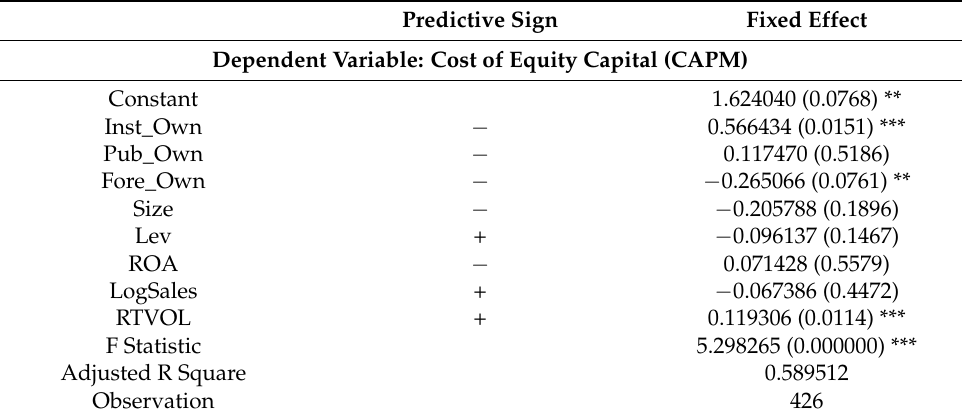
Table 5. Ownership structure and cost of equity capital using the CAPM